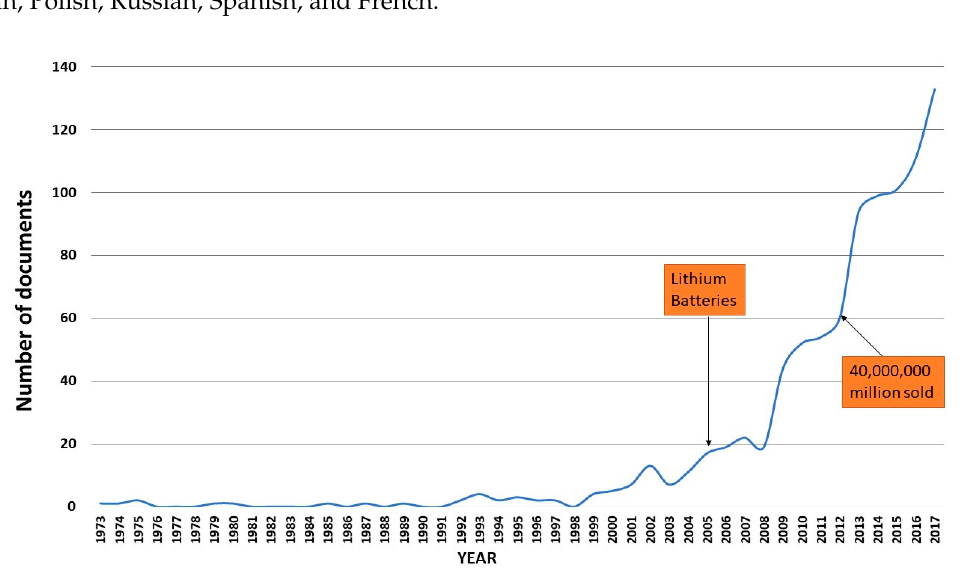
Figure 2. Evolution of the scientific production in relation to the electric bicycle (1973–2017).